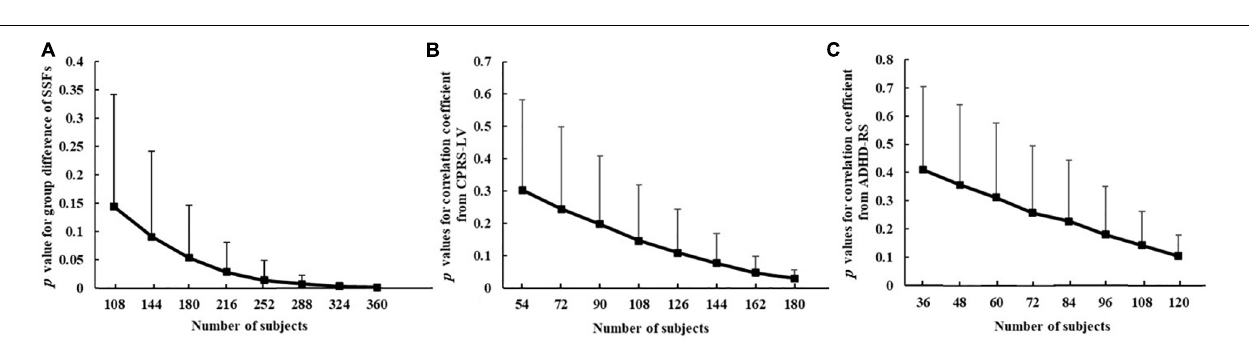
FIGURE 5 | The relationship between sample size and p -value for group difference of SSFs of the ADHD-related pattern between ADHD group and TDC group (A) , correlation coefficient between ADHD-related pattern’s expression and inattention scores from CPRS-LV (B) , and ADHD-RS (C) (ADHD, attention deficit hyperactivity disorder; TDC, typically developing control subject; CPRS-LV, Conners’ Parent Rating Scale long version; ADHD-RS, DuPaul ADHD Rating Scale